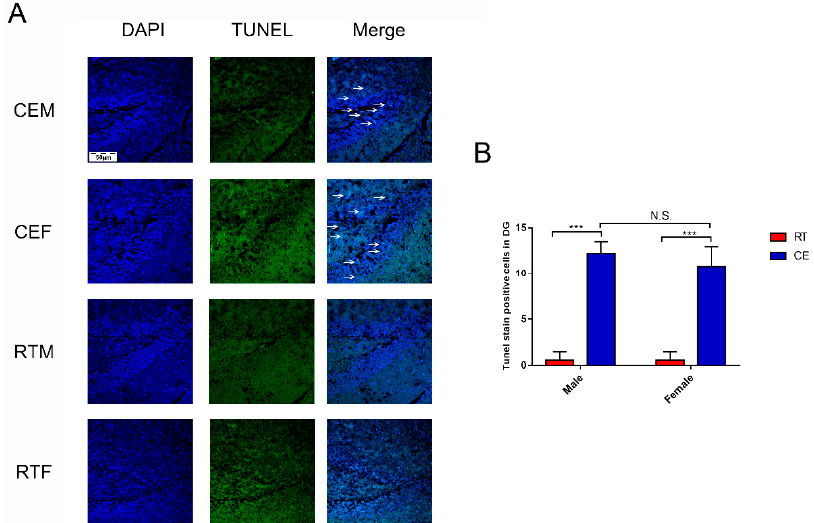
Figure 7. Apoptosis in the dentate gyrus (DG) of cold-stressed mice. ( A ) Transferase dUTP Nick End Labeling (TUNEL)-positive cells (green) counterstained with 4’,6-diamidino-2-phenylindole in the DG. Scale bar = 50 μ m. ( B ) Quantification of TUNEL-positive cells. Differences between room temperature male (RTM) and cold exposure male (CEM), room temperature female (RTF) and cold exposure female (CEF), and CEM and CEF groups were evaluated by two-way analysis of variance. Results are expressed as the mean ± SD ( n = 6) of four independent experiments. N.S.: not significant; *** p <